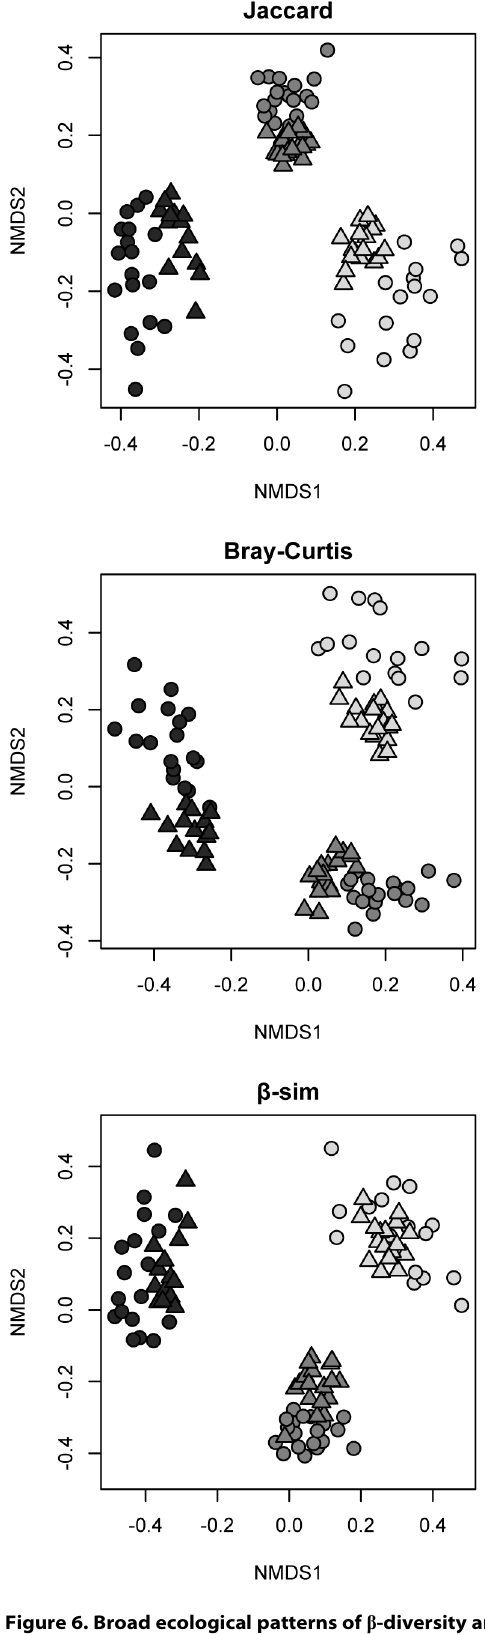
Figure 6. Broad ecological patterns of b -diversity are recovered equally well with each sequencing platform. Non-metric